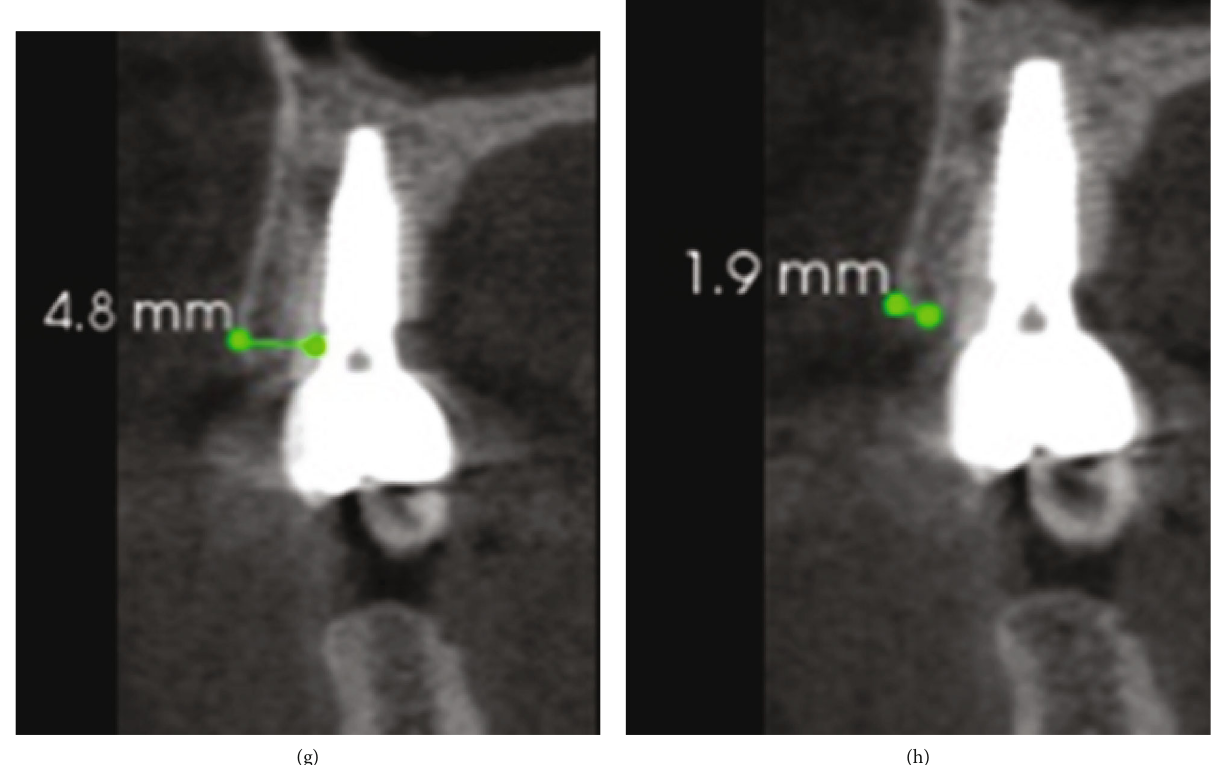
Figure 3: Zirconia crown cemented onto titanium abutment (a) and (b), lateral and occlusal views of crown screwed into the implant (c) and (d), postoperative PA (e), F – L radiographic sections (f), F – L section verifying width of hard facial tissues (g), and F – L section verifying width of facial plate crest